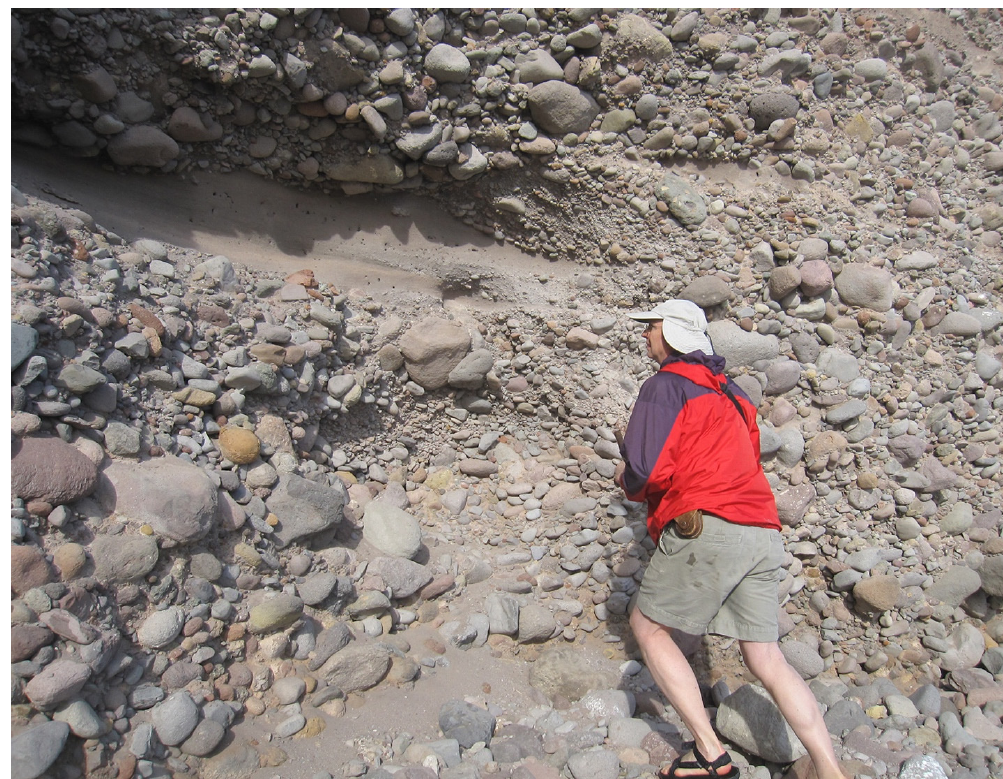
Figure 5. Exposed lower part of the Pliocene Tiombó conglomerate on the east coast of Isla del Carmen, showing typical composition of well-rounded andesite boulders parted by sandstone seams. Each of several packages offset by such seams represents a major rainfall event that carried coarse material through stream beds to the coast.